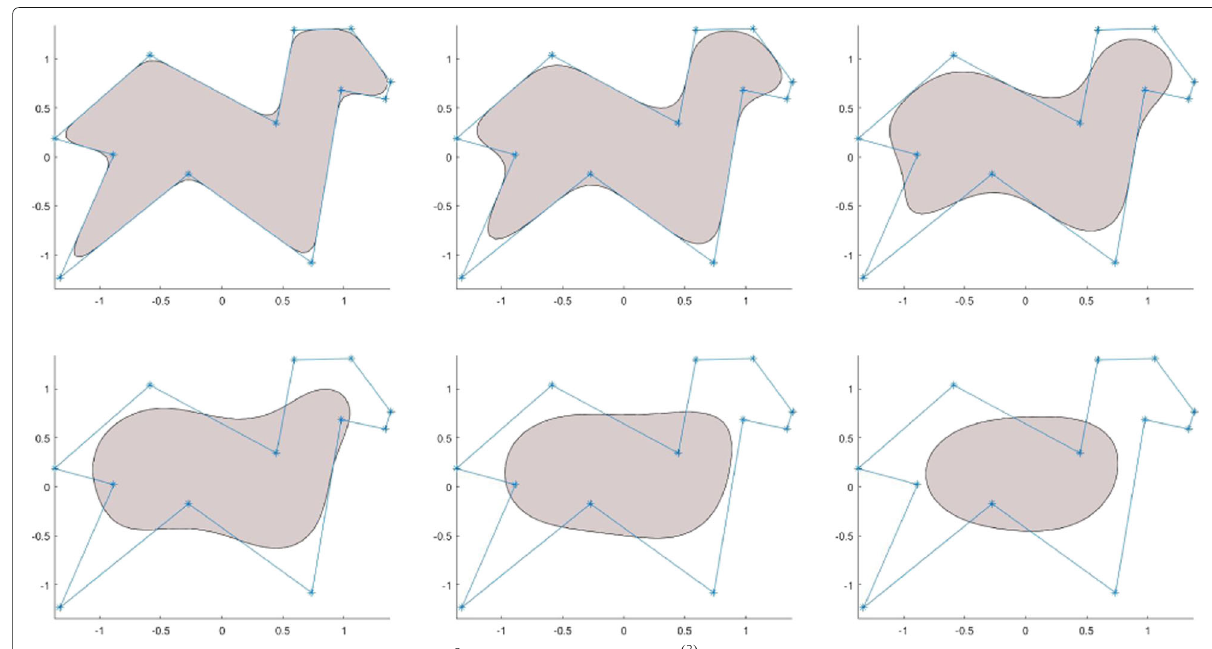
( x , y ) corresponding to the level value of less than 0.5. The , δ ··· , P 0 , P 1 , 8 . All these shapes differ only by the